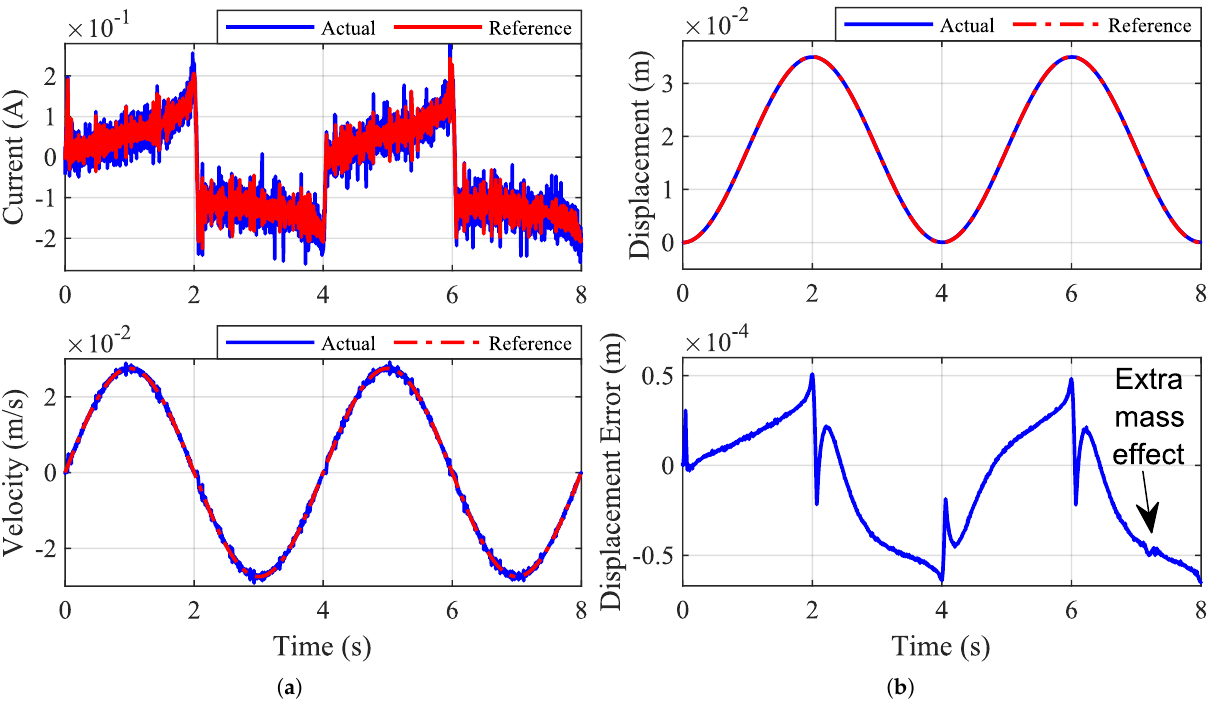
Figure 17. Experimental waveforms for sinusoidal position-tracking using the STRC method for two consecutive periods at 0.25 Hz showing the effect of extra mass when introduced in the second period. ( a ) Current and velocity; ( b ) displacement and displacement